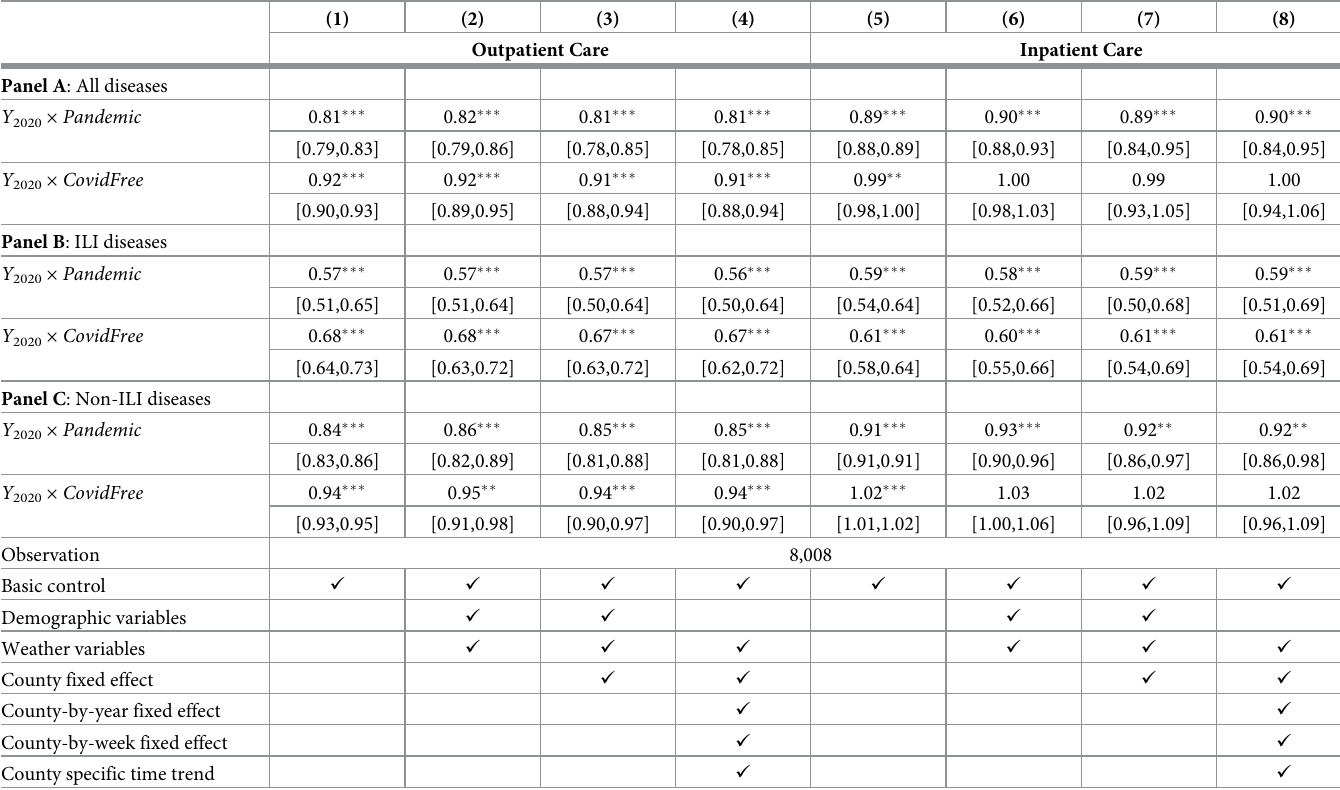
Table 3. Effects of COVID-19 outbreak on health utilization (by pandemic